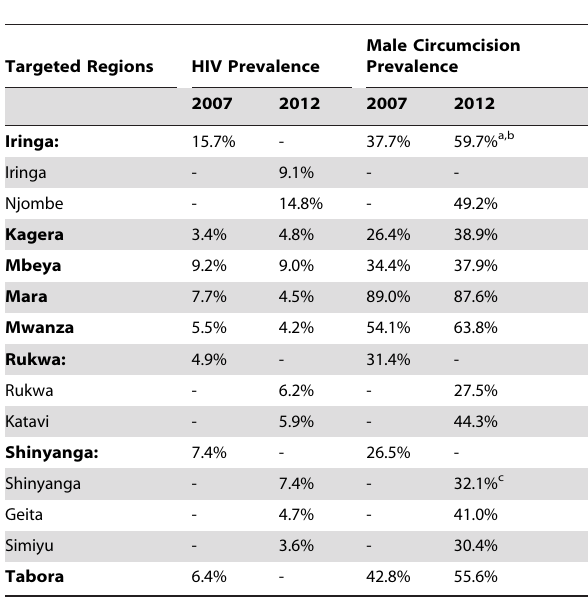
Table 1. Male HIV prevalence and male circumcision prevalence in Tanzania, 2007 and